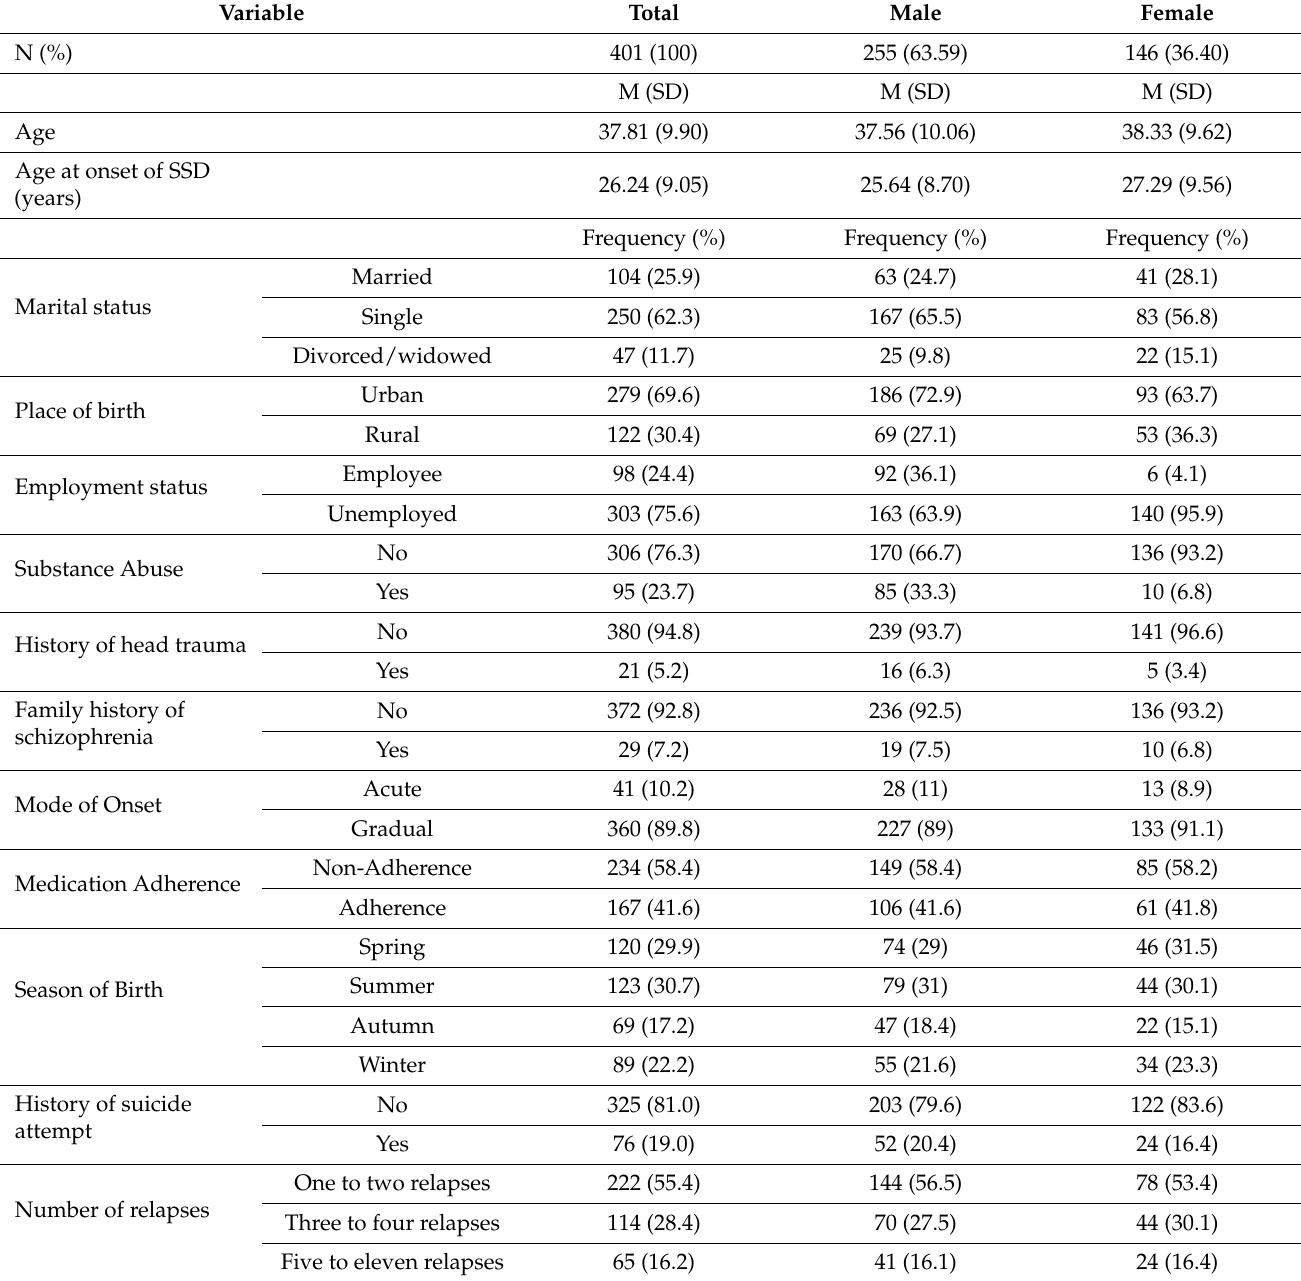
Table 1. Distribution of the characteristics, separately by